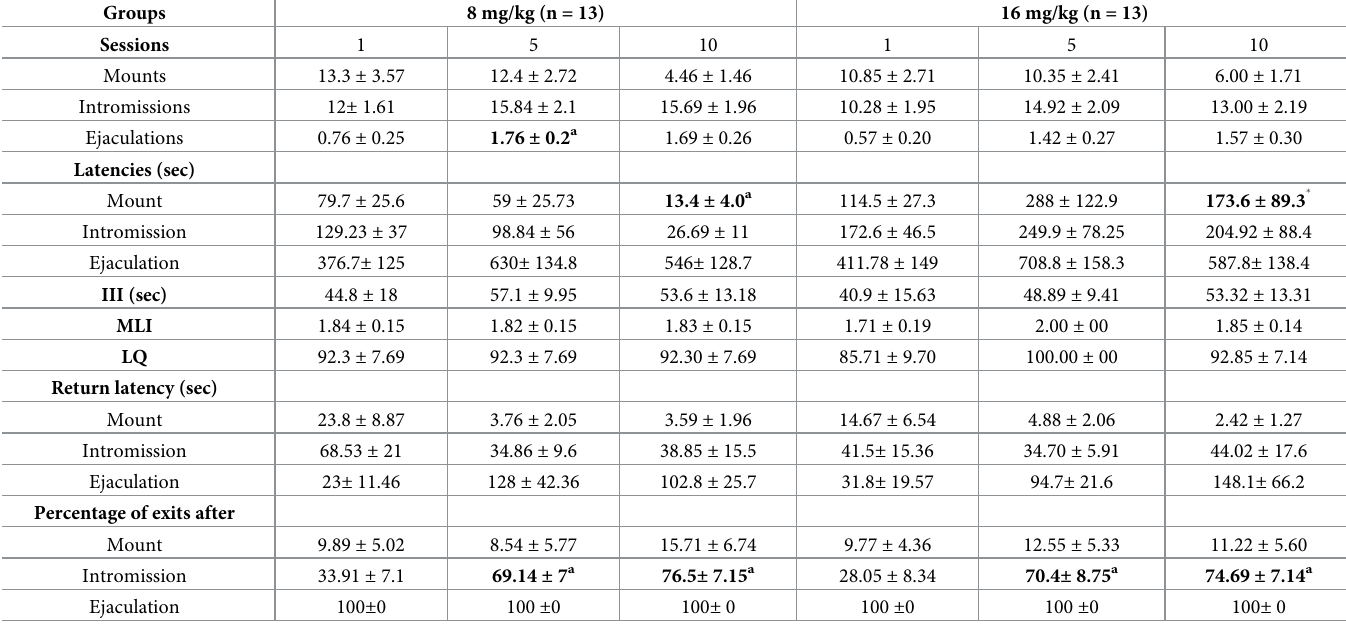
Table 2. Sexual behavior parameters in sessions 1, 5 and 10, in females treated with 8 and 16 mg/kg of MnCl 2 24 hours before testing and scanned. Data are expressed as mean ± SEM. (III: Inter intromission interval; MLI: Mean lordosis intensity; LQ: Lordosis quotient). Groups 8 mg/kg (n = 13) 16 mg/kg (n =